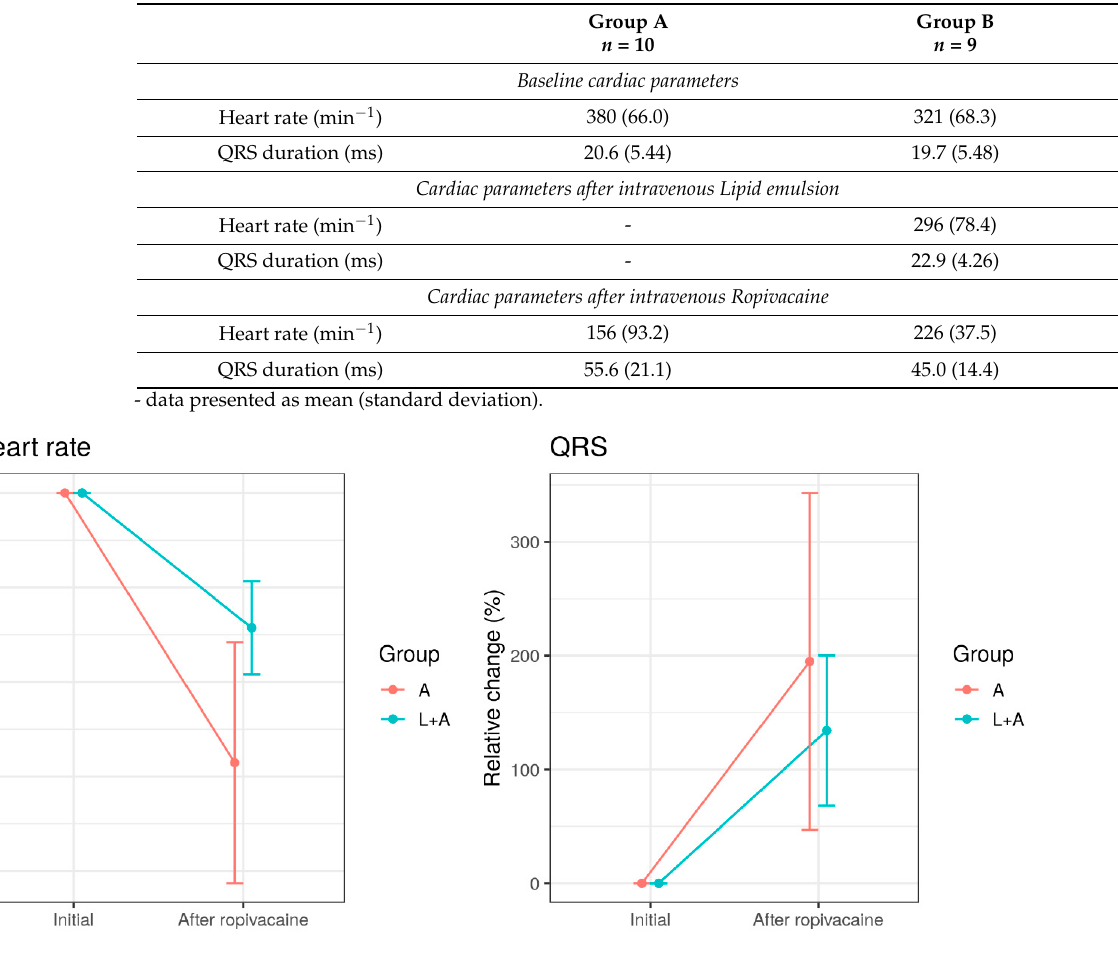
Figure 2. Administration of lipid emulsion prior to Ropivacaine (L + A) does not prove to induce relative change of heart rate and QRS complex duration in rats exposed to intravenous Ropivacaine only (A).